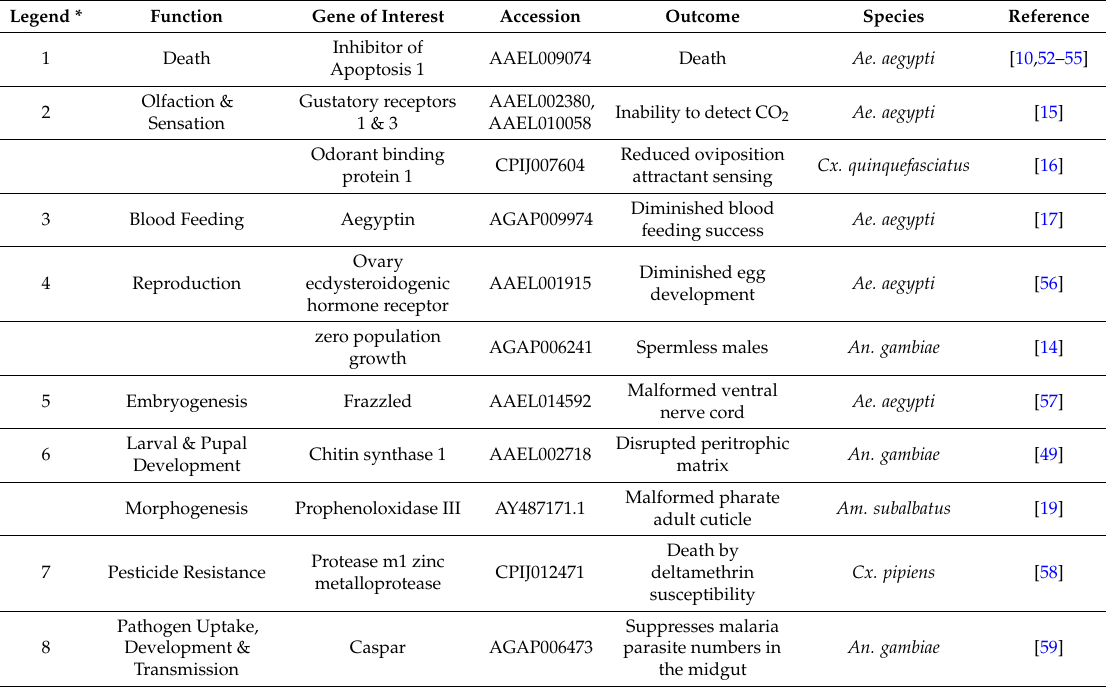
Table 1. Example target genes for RNAi and phenotypic outcomes (see also Figure